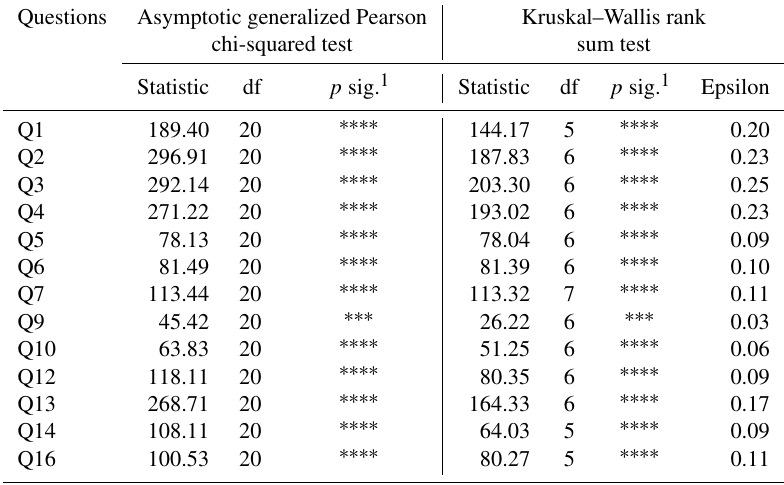
Table 2. The non-parametric-test results for the question items with Likert scale responses. For the asymptotic generalized Pearson chi- squared test (left columns), the value of statistic, the degrees of freedom of the approximate chi-squared distribution of the test statistic, and the level of significance for the p value for the test are shown. For the Kruskal–Wallis rank sum test (right columns), the same three are shown, plus the epsilon-squared measure of association for the Kruskal–Wallis test.